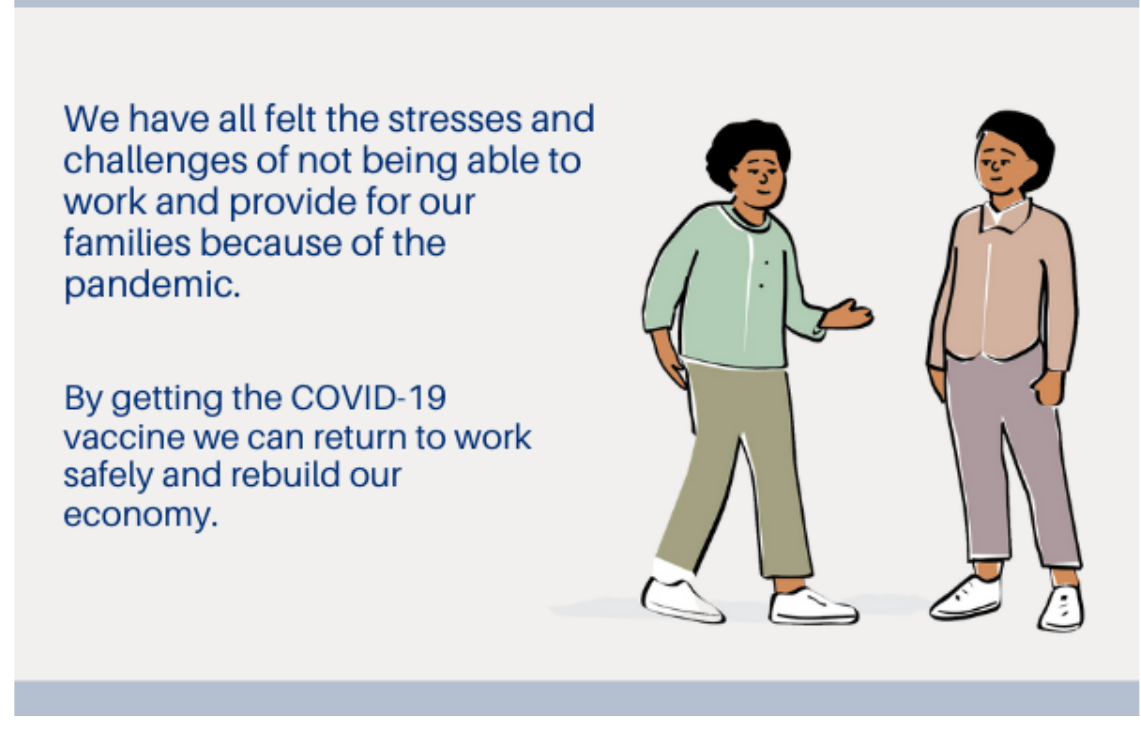
Table A1. Ukraine relative risk ratios of ad preference by vaccine hesitancy status and participant characteristics using multivariable multinomial logistic regression modeling ( n = 155)